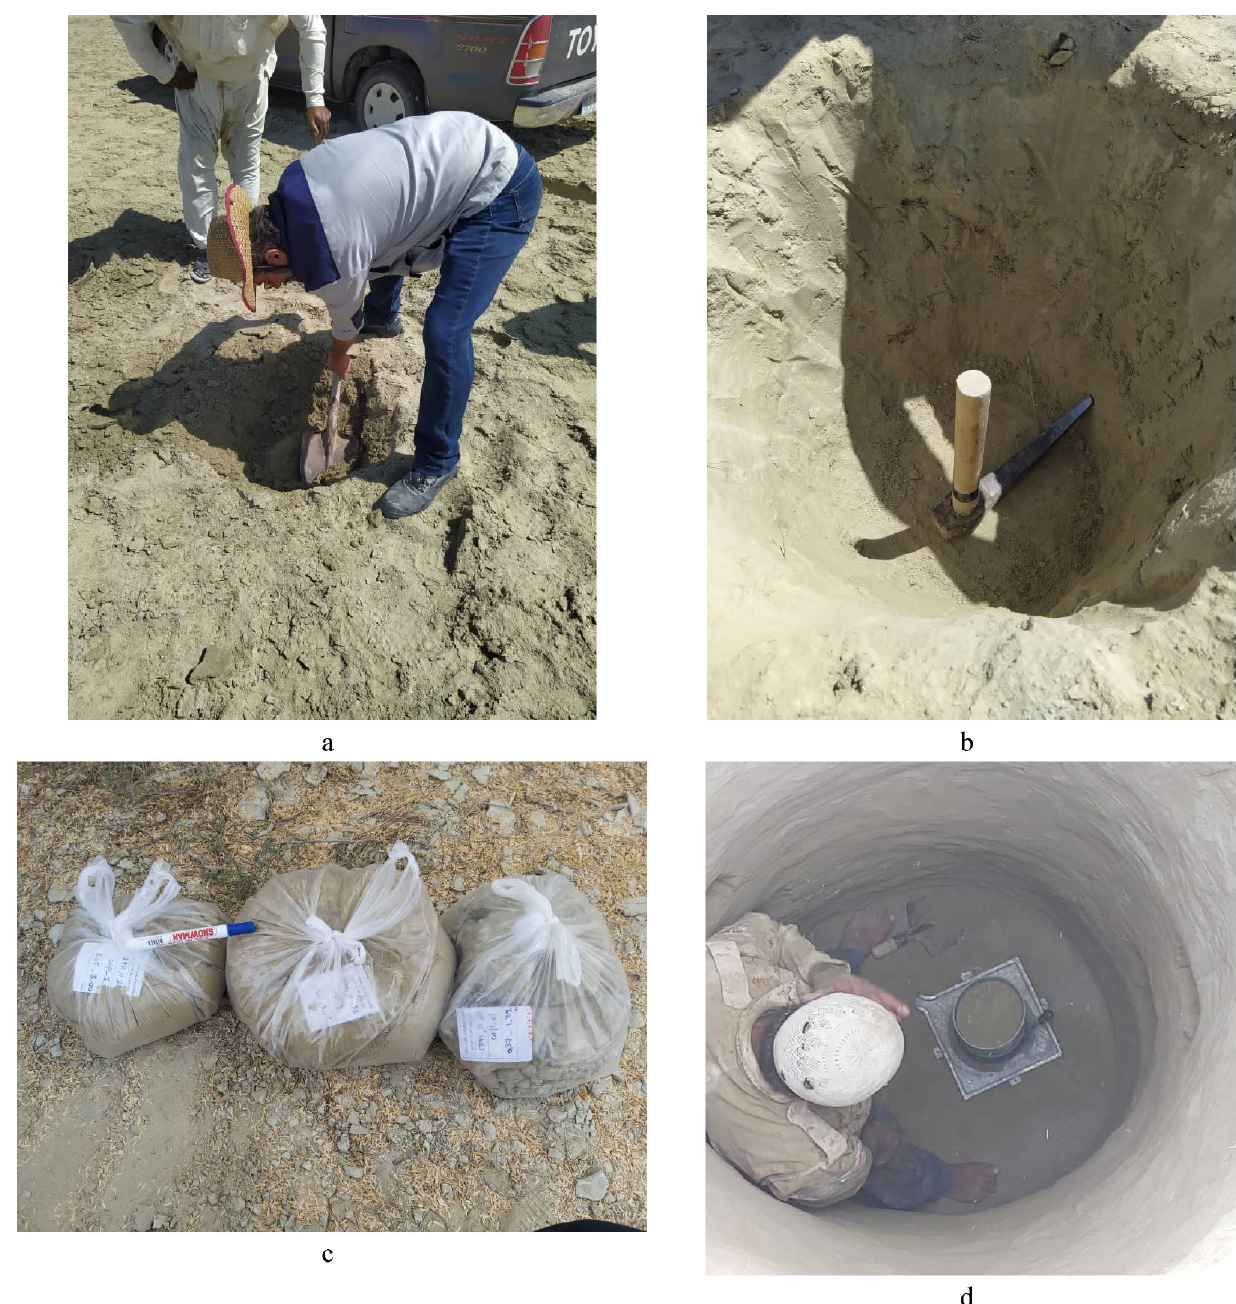
Fig. 2 a and b Different stages of drilling the hole, c sampling method, and d determination of in situ